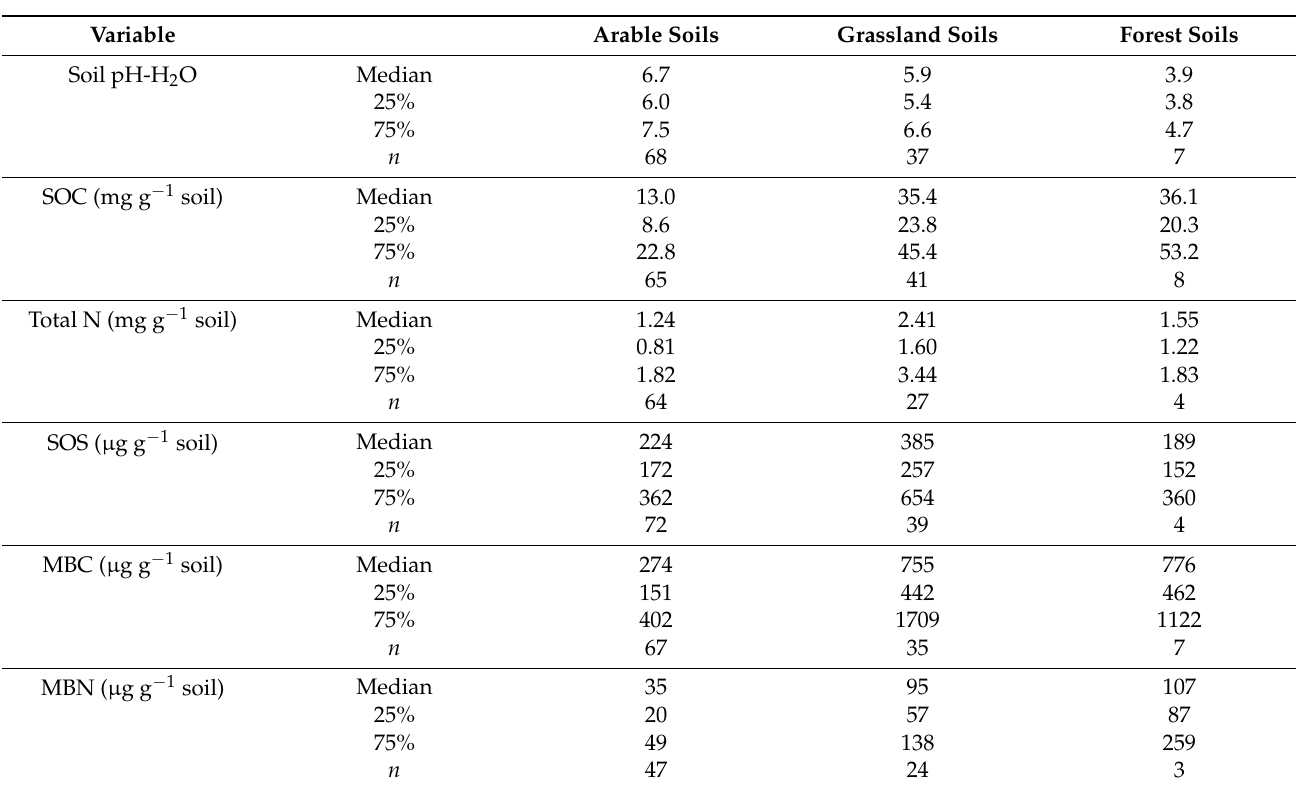
Table 1. Median, 25% and 75% as well as number of observations ( n ) for basic chemical and biological properties in arable, grassland, and forest